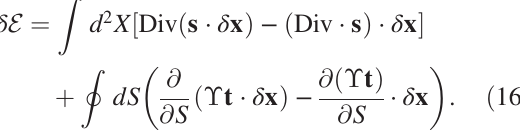
FIG. 3. Elastic stress along the free surface near the ridge singularity (symmetric ridges). (a) Pressure p versus distance to the contact line X , scaled as indicated on the axes. Data correspond to the situation without a Shuttleworth ( c 0 = γ 0 . (b) Pressure p versus distance to the contact line x , scaled as indicated on the axes. Data correspond to the varying the ratio γ LV ¼ 1 ) with different amounts of prestretch λ situation with a Shuttleworth ( c 0 ; 1 scaled as indicated on the axes. Data correspond to the same cases as in